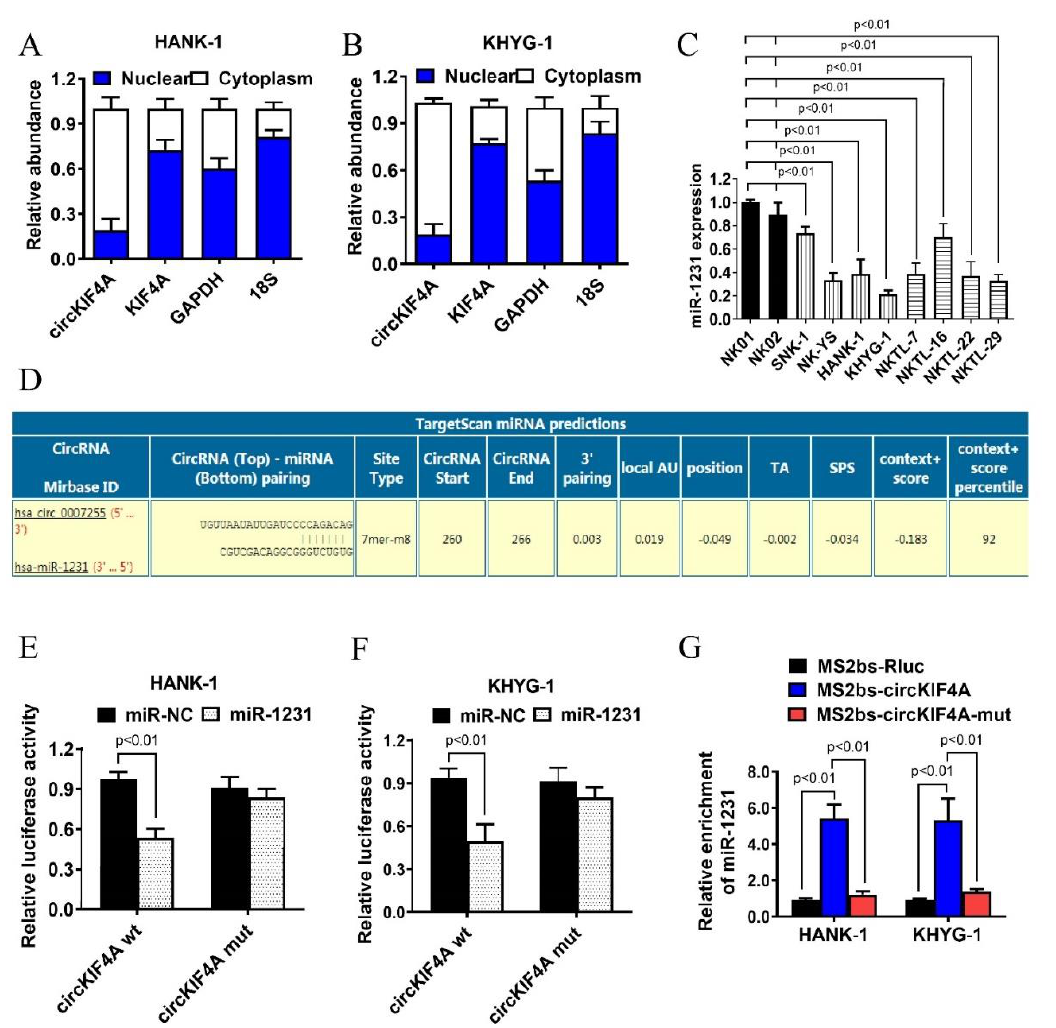
Figure 4. CircKIF4A functions as an miR-1231 sponge in NKTL. ( A , B ) Levels of the nuclear control (18S), cytoplasmic control (GAPDH), circKIF4A, and KIF4A. ( C ) MiR-1231 expression in the NKTL cell lines, SNK-1, NK-YS, HANK-1, KHYG-1, NKTL-7, NKTL-16, NKTL-22, and NKTL-29, and in the normal NK cell lines, NK01 and NK02. ( D ) Predicted miR-1231 binding site in circKIF4A. ( E , F ) Luciferase assay in HANK-1 and KHYG-1 cells transfected with miR-1231 mimics along with wild type or mutant circKIF4A luciferase reporters. ( G ) MS2-based RIP assay in cells transfected with MS2bs-circKIF4A, MS2bs-circKIF4A-mut, or